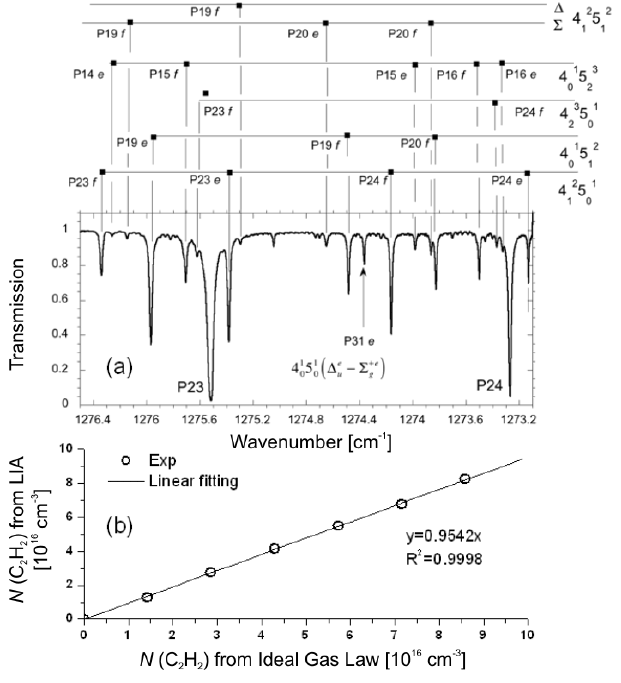
Figure 3. Sample spectrum and calibration curve of a stable molecular species, C obtained with a pulsed QCL at elevated pressure. (a) Transmission spectrum of a room temperature sample (19 cm absorption path) exhibiting no rapid passage features due to higher pressure (>50 mbar [30]). (b) C integrated absorption coefficient (LIA) of line P (23, e ) for various experimental conditions at 298 K [56] (reprinted with permission from [56]. Copyright 2009, American Institute of